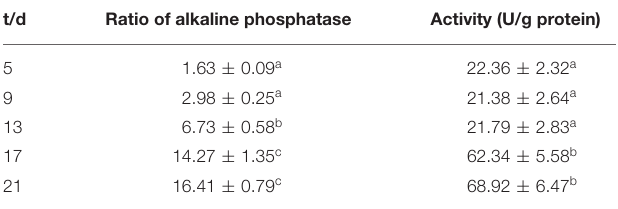
TABLE 3 | Relationship between alkaline phosphatase activity and culture time of Caco-2 monolayer. t/d Ratio of alkaline phosphatase Activity (U/g